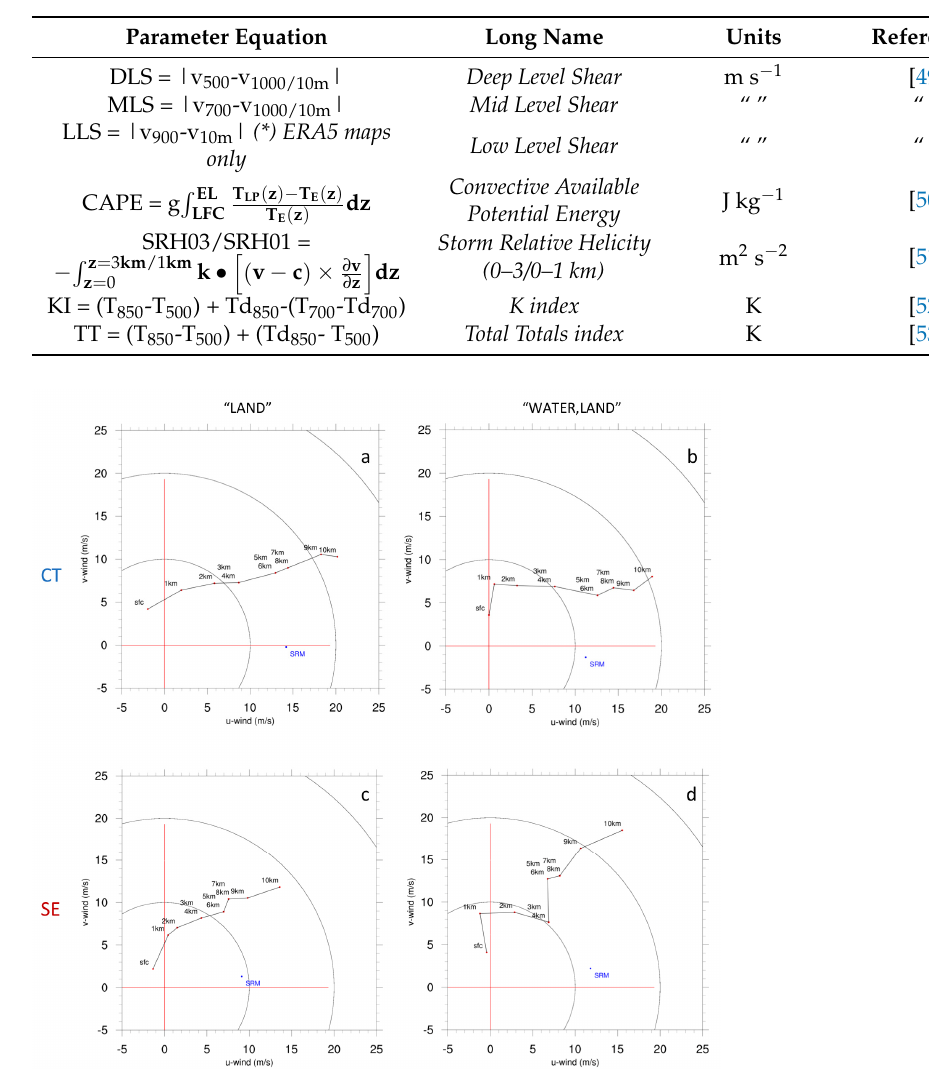
Table A1. Equations, units, and main references for some of the calculated parameters. v is the horizontal wind vector (the numbers, when no units appear, refer to the vertical pressure level); g is the gravitational acceleration; LFC is the level of free convection; EL is the equilibrium level; TLP is the lifting parcel temperature; TE is the environmental temperature; k is the upward unit vector; c is the storm motion vector; T is the temperature; Td is the dew point temperature.